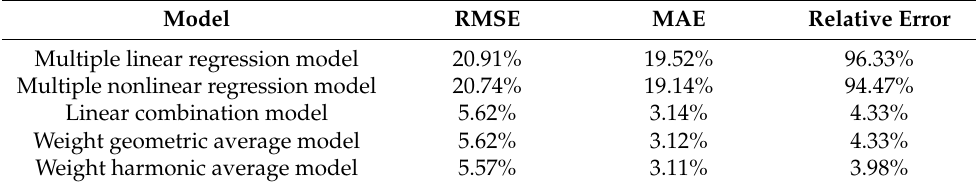
Table 4. The evaluation results of the model accuracy. Model RMSE MAE Relative Error Multiple linear regression model 20.91% 19.52% 96.33% Multiple nonlinear regression model 20.74% 19.14% 94.47% Linear combination model 5.62% 3.14% 4.33% Weight geometric average model 5.62% 3.12% 4.33% Weight harmonic average model 5.57% 3.11%